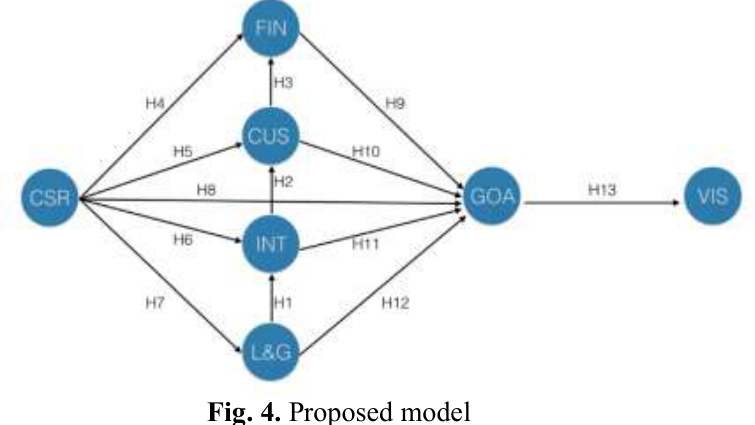
Fig. 4. Proposed model